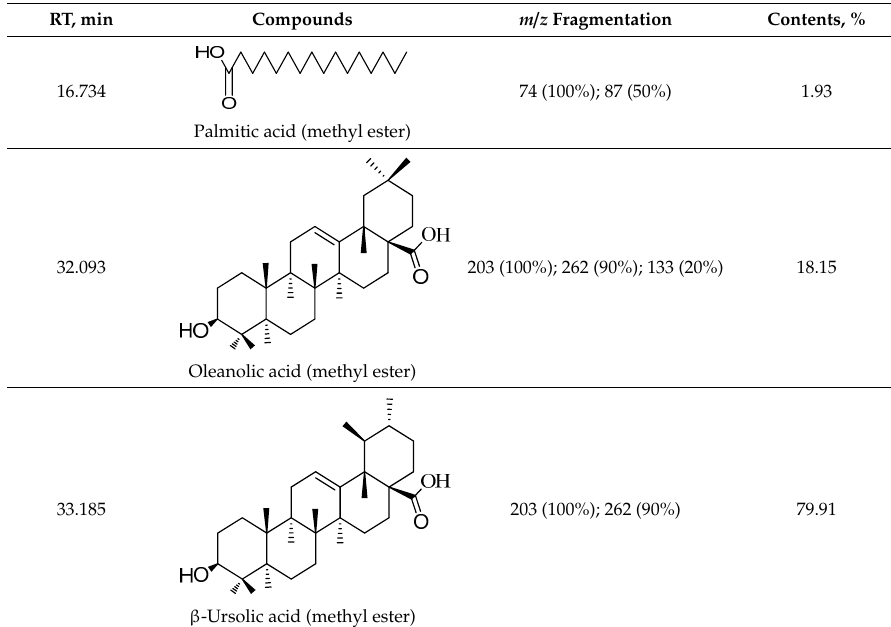
Figure 4. UV-Visible spectrophotometer absorption spectrum of triterpenoids, extract from D. heterophyllum ( A ), total triterpenoids solution from D. heterophyllum ( B ), λ , 547 nm.